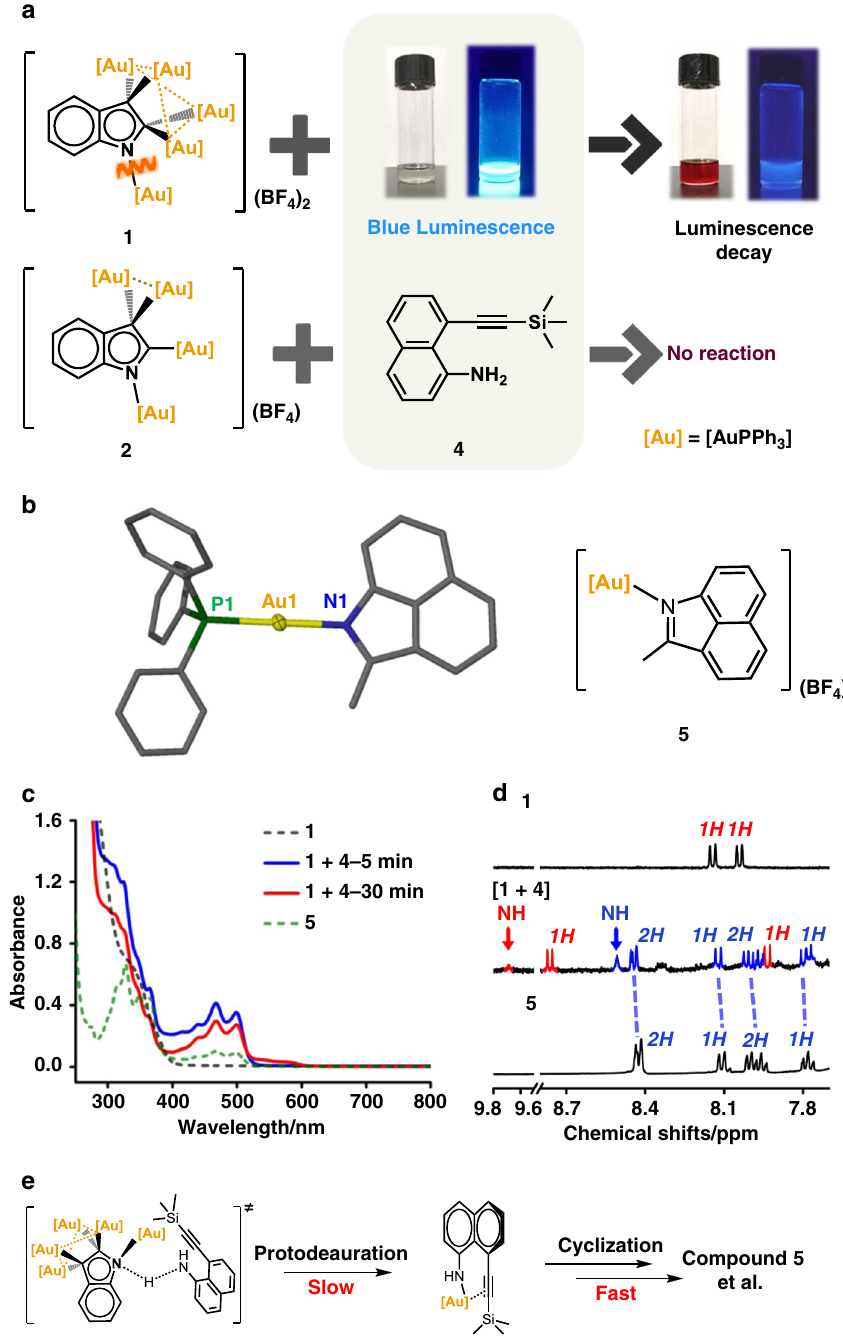
Fig. 5 Protodeauration reactivity of 1 and 2. a Schematic reaction procedures of 1 and 2 with 4 . b Crystal structure of 5 . Hydrogen atoms and tetra fl uoroborate counter anions are omitted for clarity. c UV-vis spectra (CH 2 Cl 2 , 298 K, c = 50 μ M) of the reaction mixture of 1 and 4 , and complexes 1 and 5 . d 1 H-NMR spectra (CD 2 Cl 2 , 298 K) of complexes 1 and 5 , and the products derived from the [ 1 + 4 ] mixture. e Proposed protodeauration step between 1 and 4